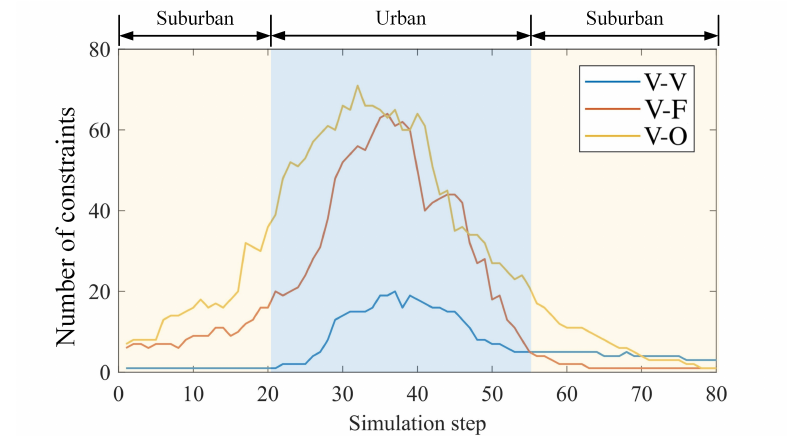
Figure 7. Amount of constraints used at every simulation